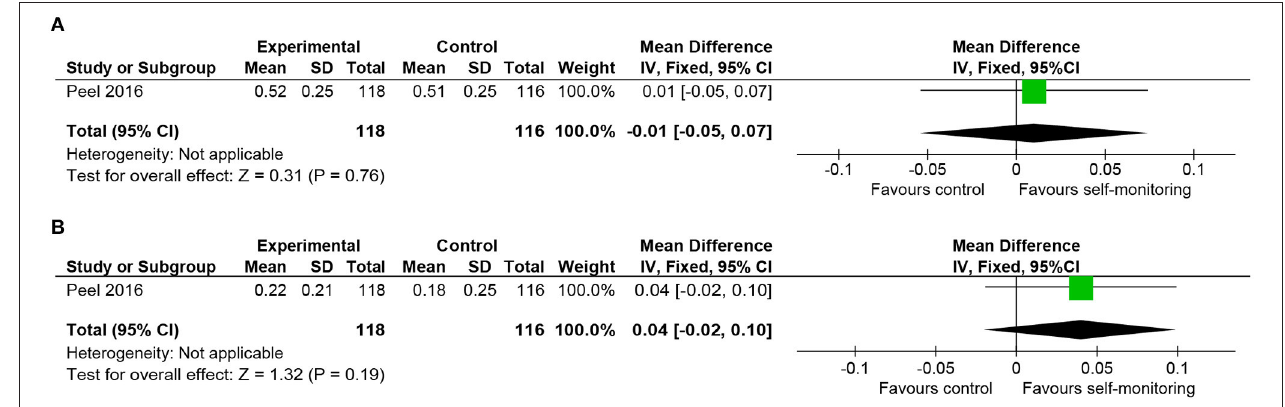
FIGURE 9 | Comparison of walking ability in rehabilitation of geriatric patients. (A) Gait speed (self-selected, m/s) post-intervention. (B) Gait speed (self-selected, m/s) change from baseline. SD, standard deviation; IV, inverse variance method; CI, confidence interval.